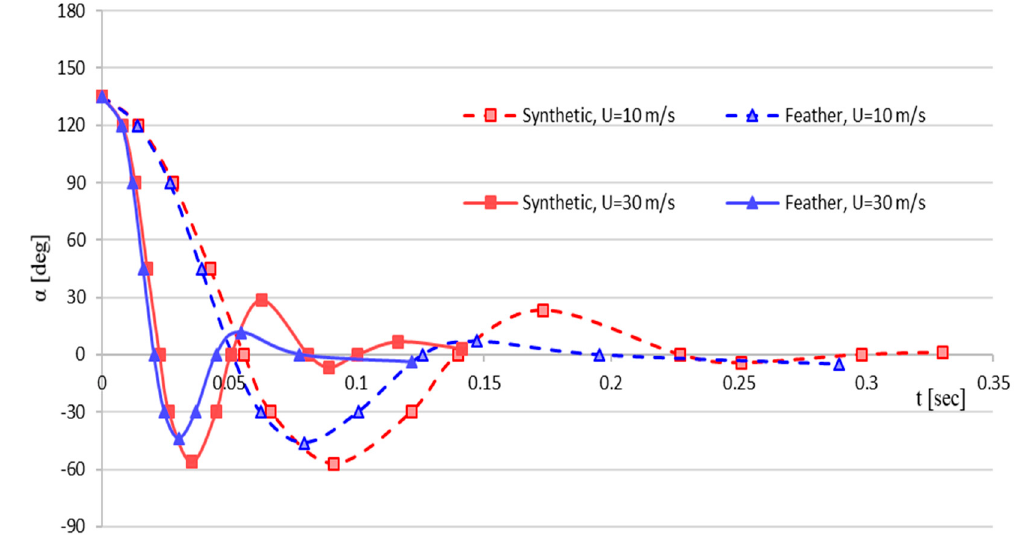
Figure 3. Time evolution of the angle of attack during the flip movement at U 0 = 10 and 30 m/s ( Re = 4.4 × 10 4 and 1.3 × 10 5 .). Triangular plots show the feather shuttlecock results, and square plots show the synthetic shuttlecock results. The solid line shows U 0 = 30 m/s, and the broken line shows U 0 = 10